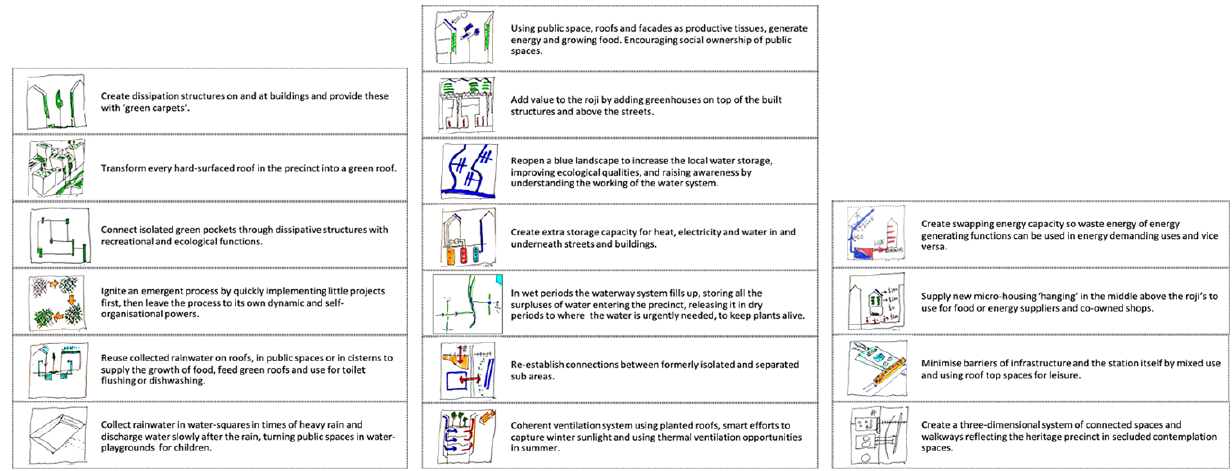
Figure 11. Spatial principles for slowly, moderately and rapidly transforming